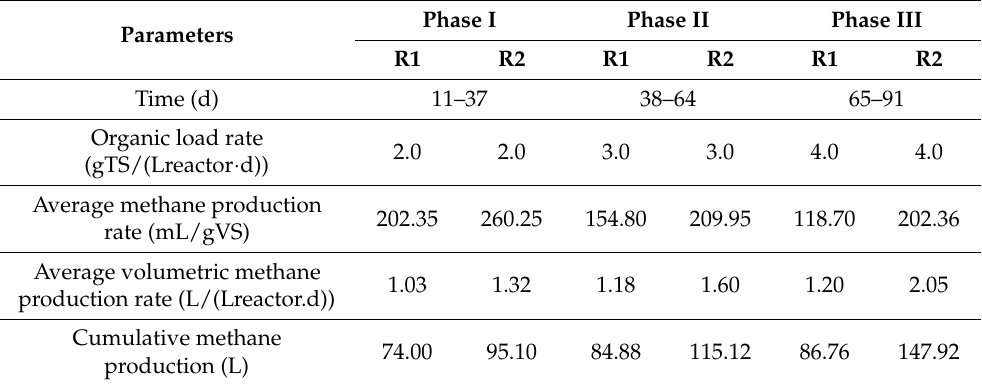
Table 2. Methane production performance at each phase in AD